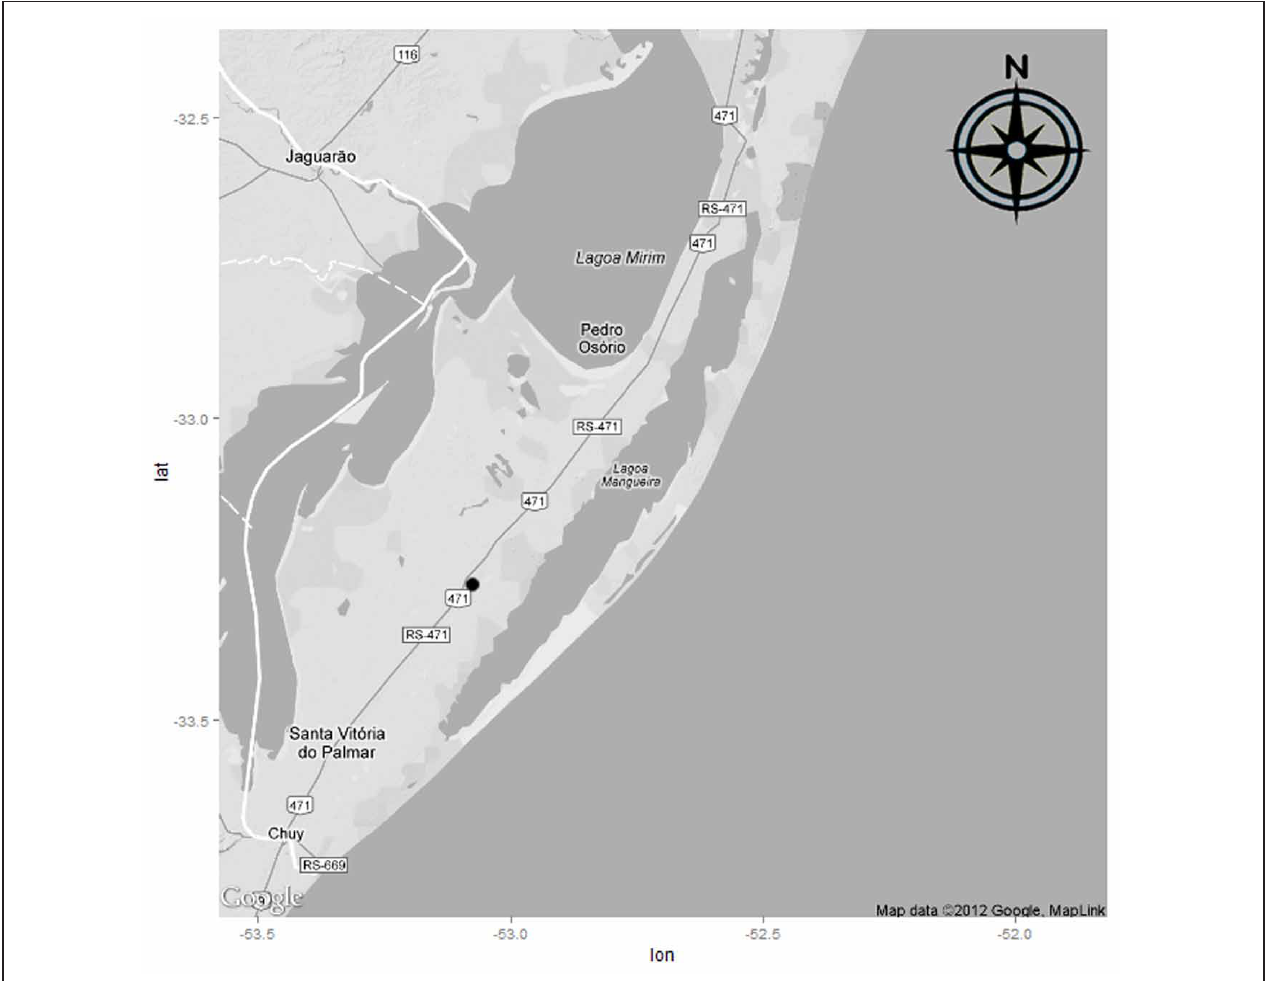
FIGURE 1 | Mangueira Lake, a large coastal lake in the state of Rio Grande do Sul, Southern Brazil, and localization of rice fields sampled ( (cid:129)